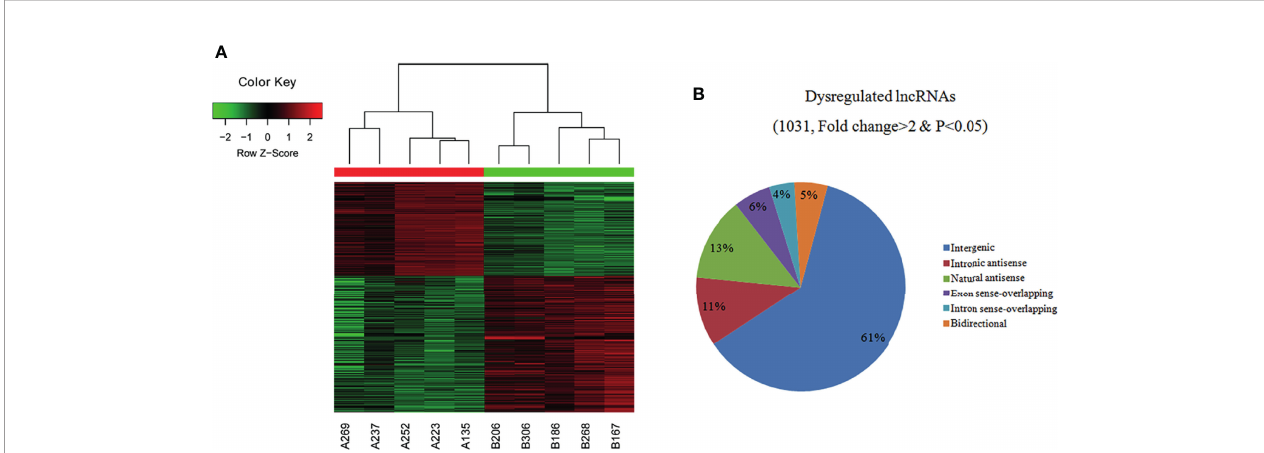
FIGURE 1 | Heat maps showing the differential expression and hierarchical clustering of lncRNAs (A) in PTC/HT (+) versus PTC/HT (-). “ Red ” indicates high relative expression, and “ green ” indicates low relative expression. The classi fi cation and proportions of dysregulated lncRNAs are shown according to their relationships with their associated protein-coding genes (B)